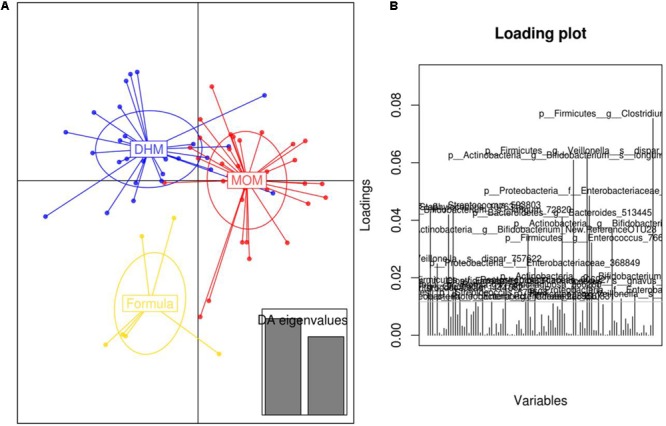
Discriminant analysis of principal components (DAPC) plot (A) at OTUs level revealed distinct clustering of the MOM (red), DHM (blue), and formula-fed group (yellow). Canonical loading plot (B) showing differentially abundant bacterial genera. The individual peaks show the magnitude of the influence of each variable on separation of the groups (0.05 threshold level).